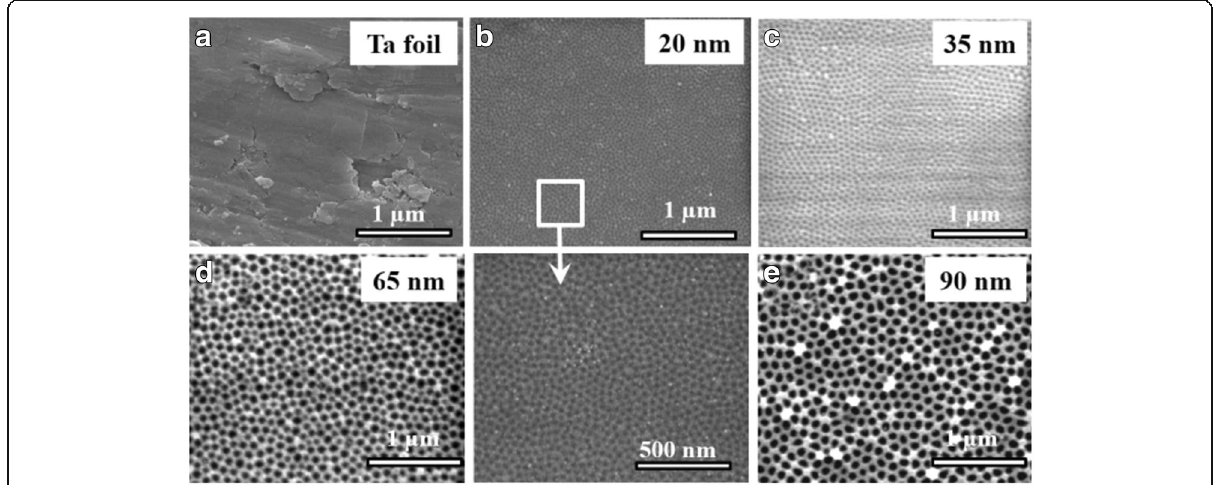
Fig. 1 SEM images showing the a Ta foil surface and self-organized TaO x nanotubes with diameters of b 20, c 35, d 65, and e 90 nm, respectively